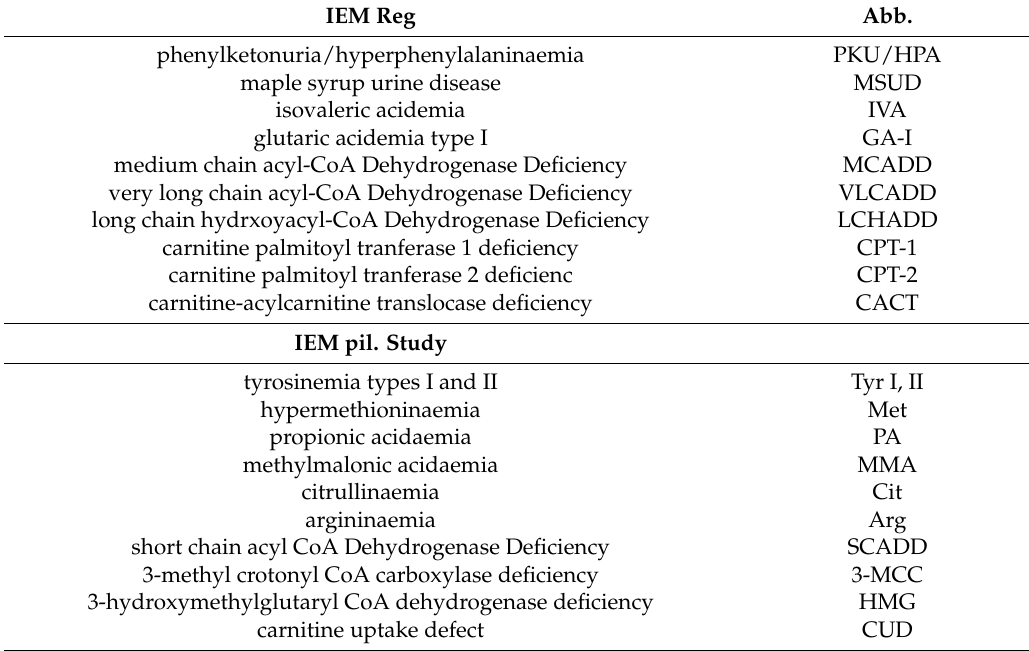
Table 1. Spectrum of IEMs in extended newborn MS/MS screening since 1 January